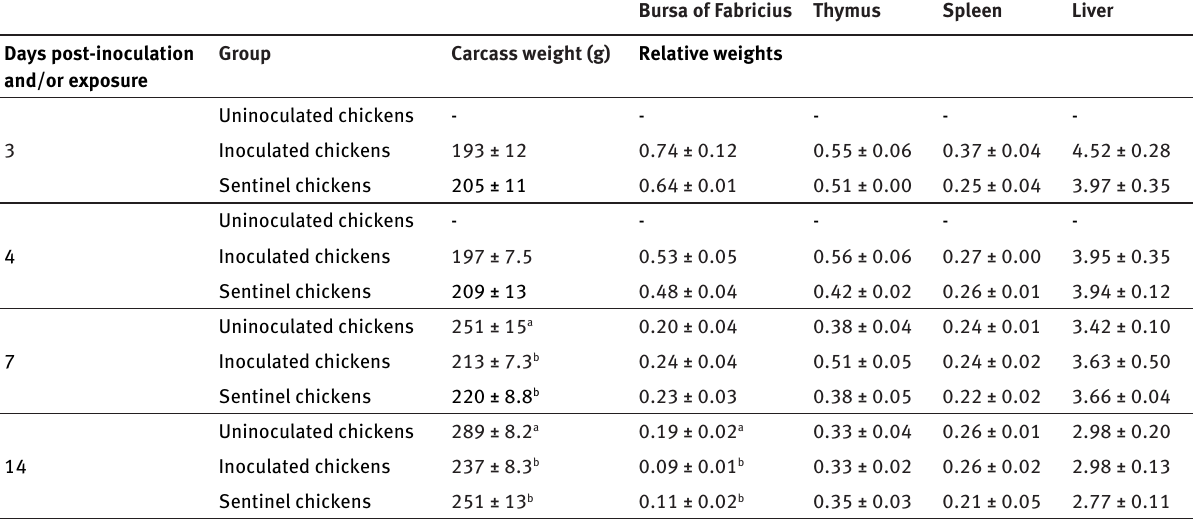
Bursa of Fabricius Thymus Spleen Liver